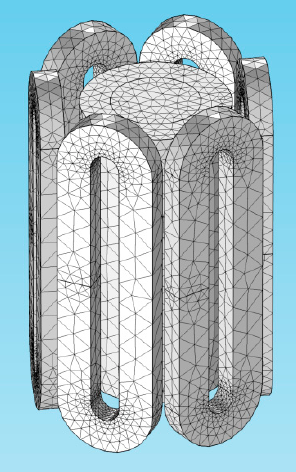
Figure 14. Mesh of the 3D Finite Element (FE) magnetostatic model of the prototype.